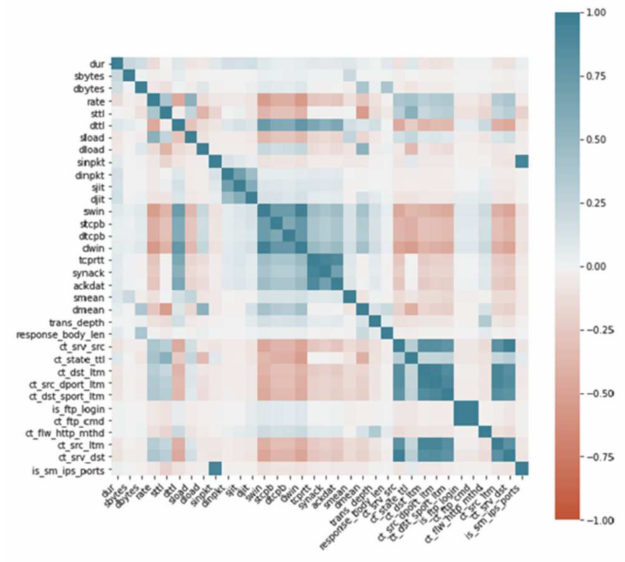
Figure 2. Correlation